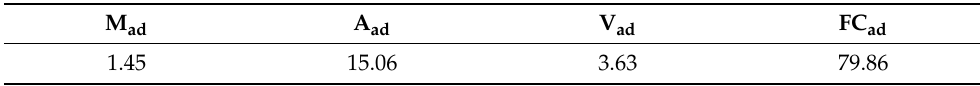
Table 3. Proximate analyses of coal (air-dry